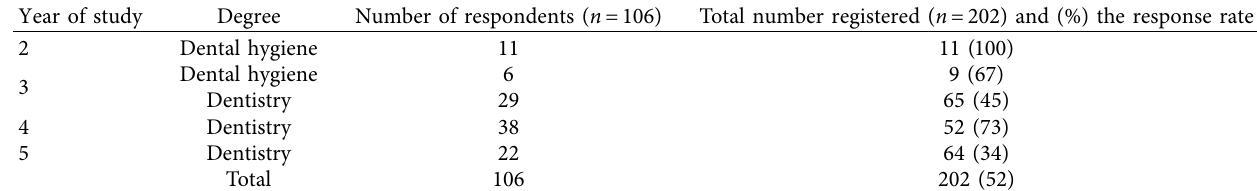
Table 1: Number of respondents per year of study and degree ( n � 106).